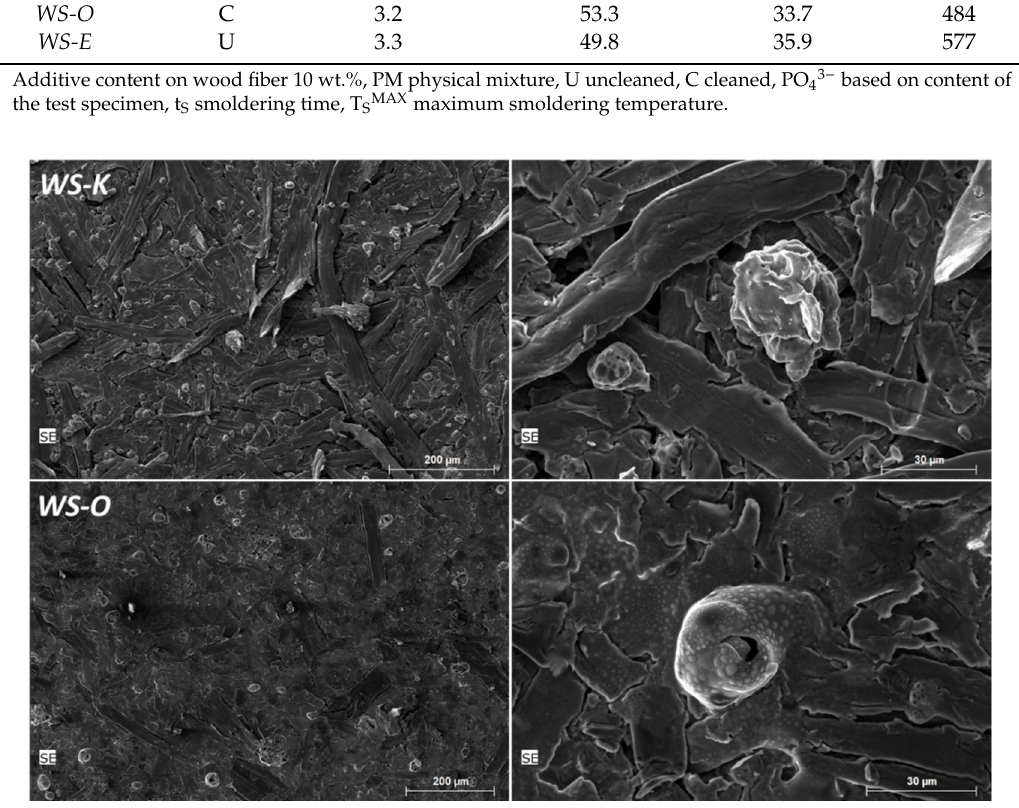
Figure 5. SEM images of wood fibers with 10 wt.% wheat starch-based FR WS-K (poorly soluble) and WS-O (well soluble) after heating to 350 °C in the oven (heating rate 10 K/min), recordings by Björn Günther using FEI Quanta ™ FEG 650.